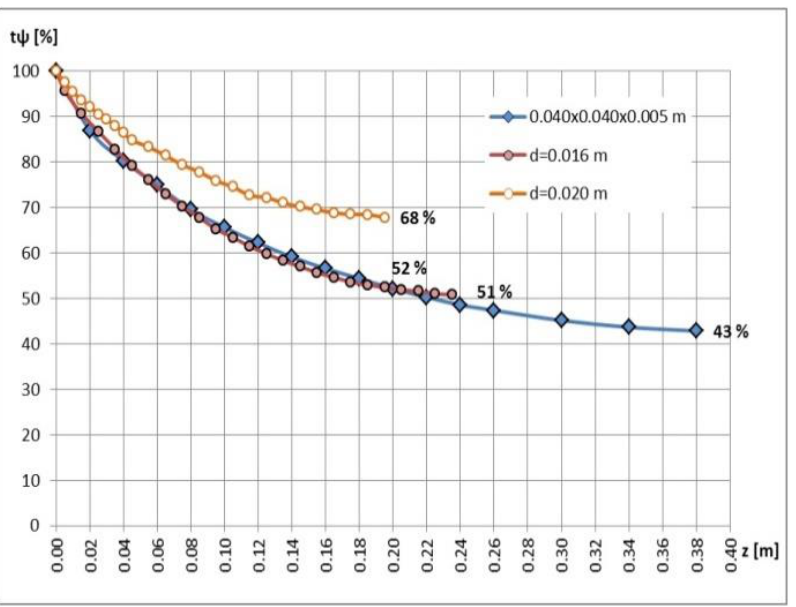
thermal distribution laws for = 0 